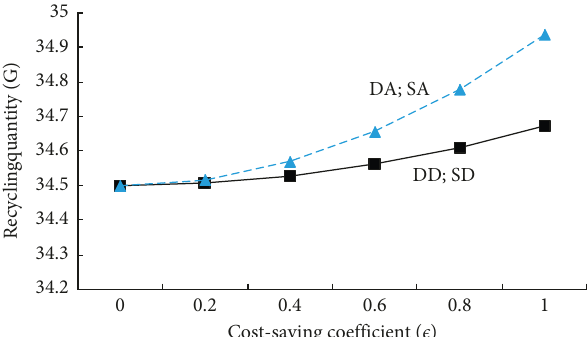
Figure 3: The effect of ϵ on quantity of recycled product (a) the effect on carbon emissions (b) the effect on profit of the recycler.